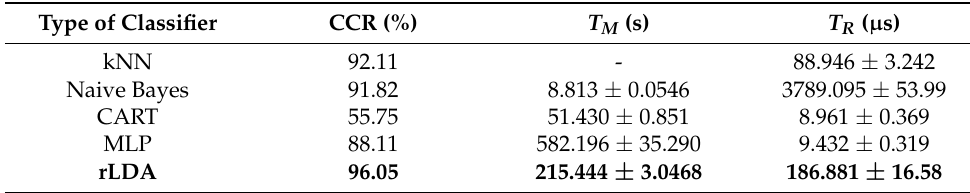
Table 8. Classification results for individual classifiers with Group 7